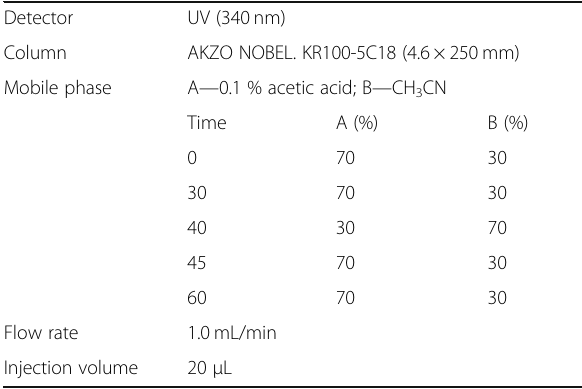
Table 5 HPLC analysis conditions of AI